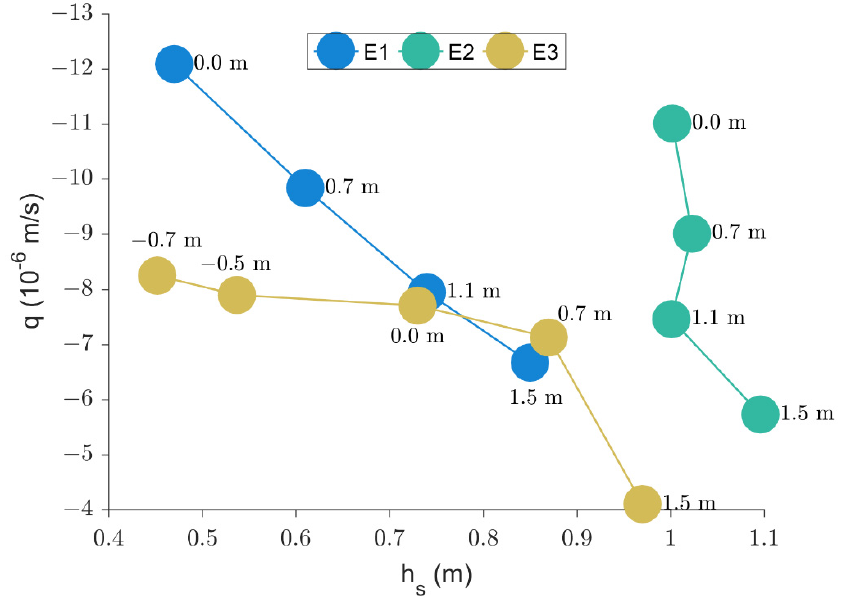
Figure 5. Experimental infiltration flux (q) and pore water pressure head from the tensiometer (h z ). The negative infiltration flux indicates the downward infiltration direction. The numbers near each dot present the pressure head at the bottom boundary (h s